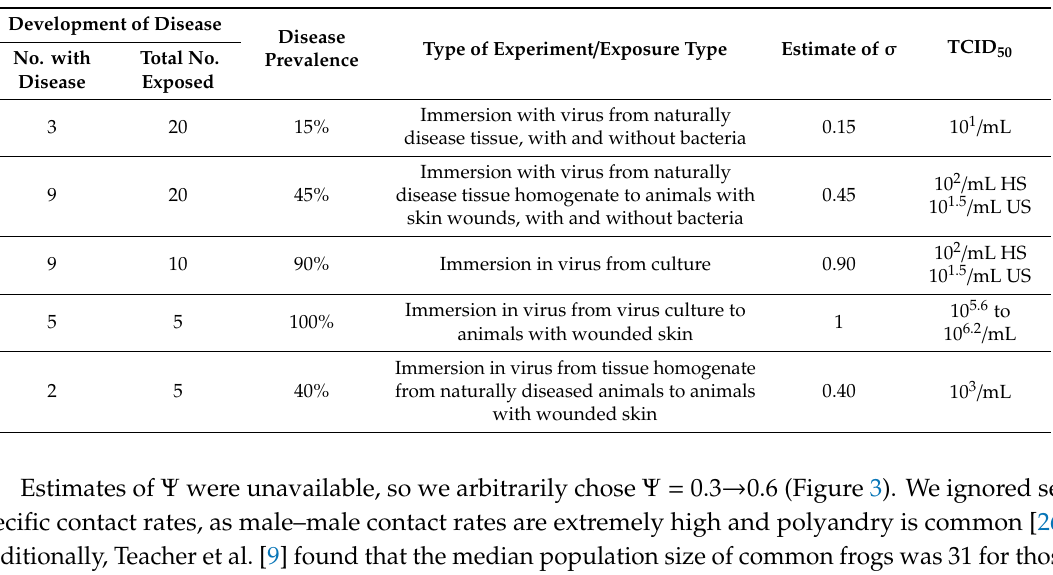
Table 1. Estimates for σ derived from the literature. Note: Experiments where the exposure was via inoculation have not been included in these estimates. No distinction has been made between the types of ranavirus-associated disease that the virus was derived from. Development of disease data, TCID 50 and type of experiment information are summarized from Cunningham et al. [25]. (HS = Hemorrhagic and US = Ulcerative forms of ranavirosis.).